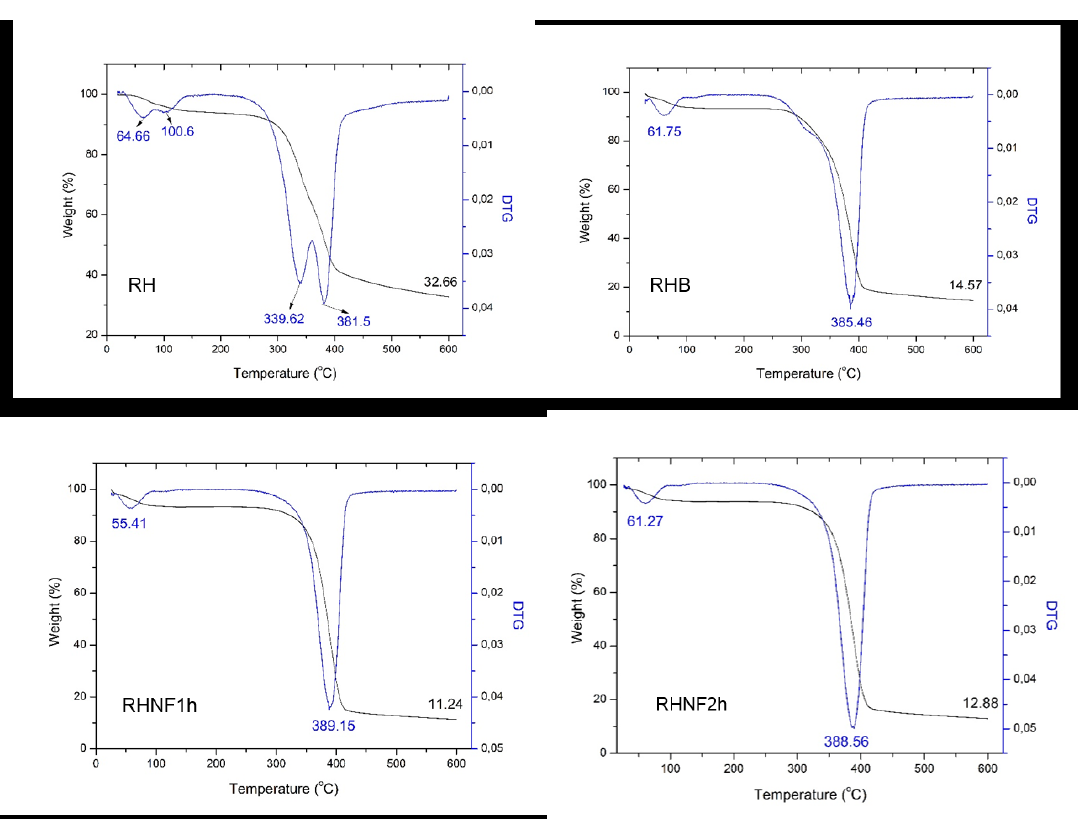
Figure 5. TGA curves of RH, RHB, RHNF1h and